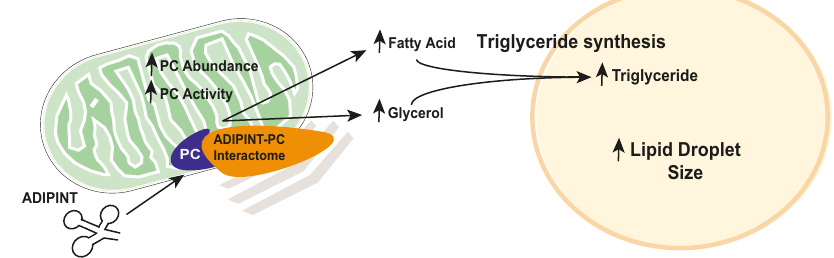
Fig. 7 Current working model for the effect of the ADIPINT-PC interaction on fat cell metabolism. ADIPINT interacts with PC regulating its interactome which results in an increased abundance and activity of PC within the mitochondria. The increase in PC activity leads to an increase in triglyceride synthesis in the adipocyte regulating the lipid